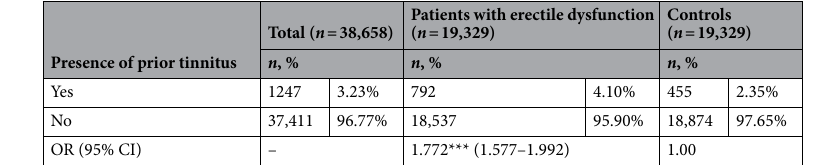
Table 2. Prevalence of tinnitus and crude odds ratio of prior tinnitus among cases vs. controls. OR odds ratio. ***Indicates p < 0.001.